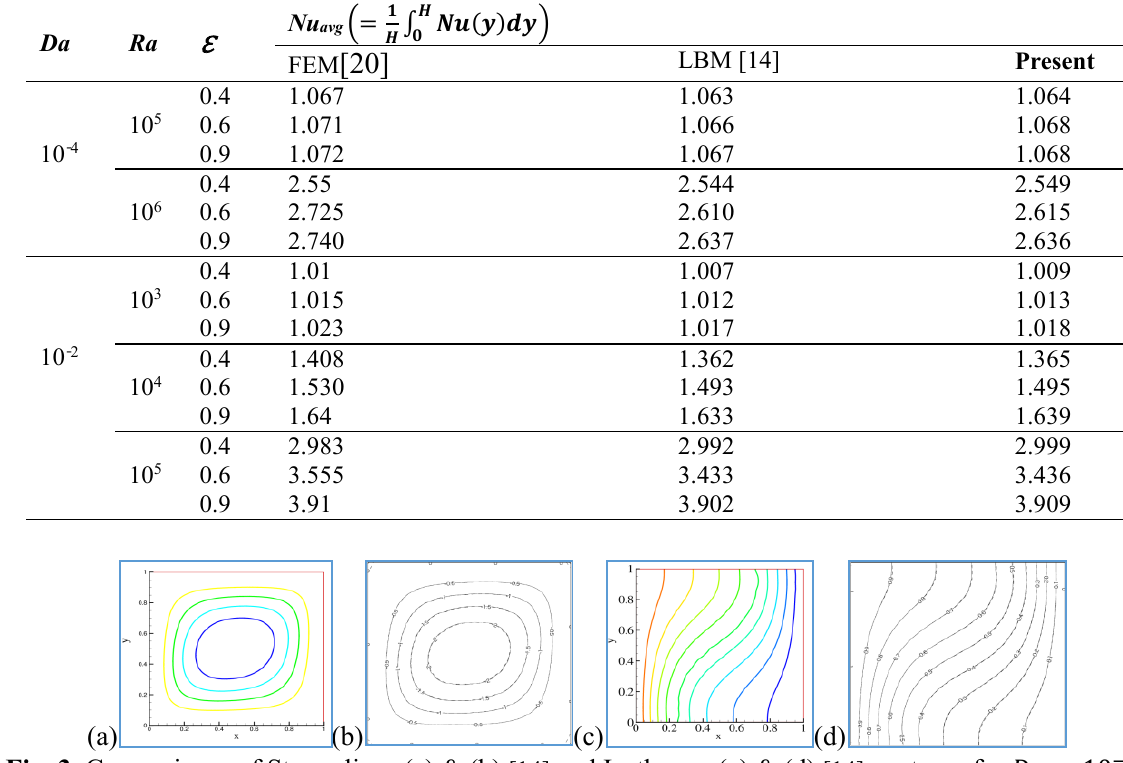
Comparative results against the Brinkman-Forchheimer model at Pr =1.0 .